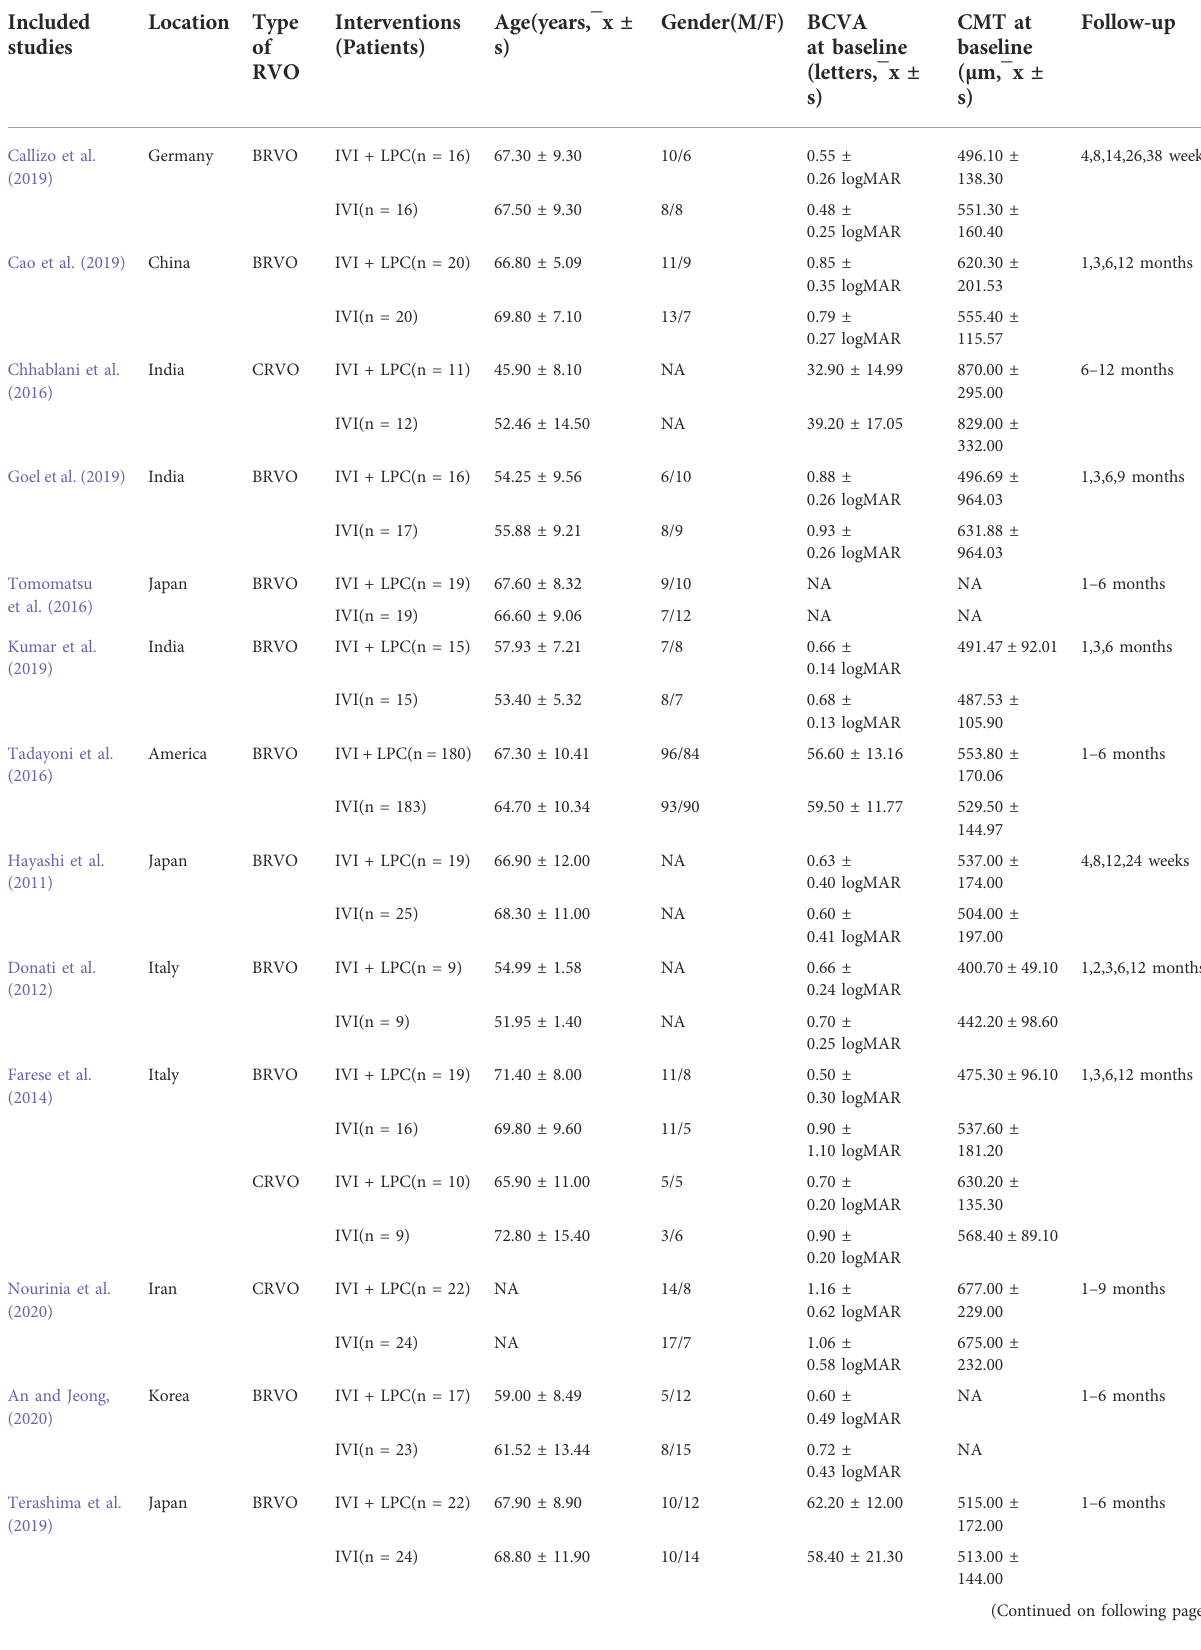
TABLE 1 General imformation of the included